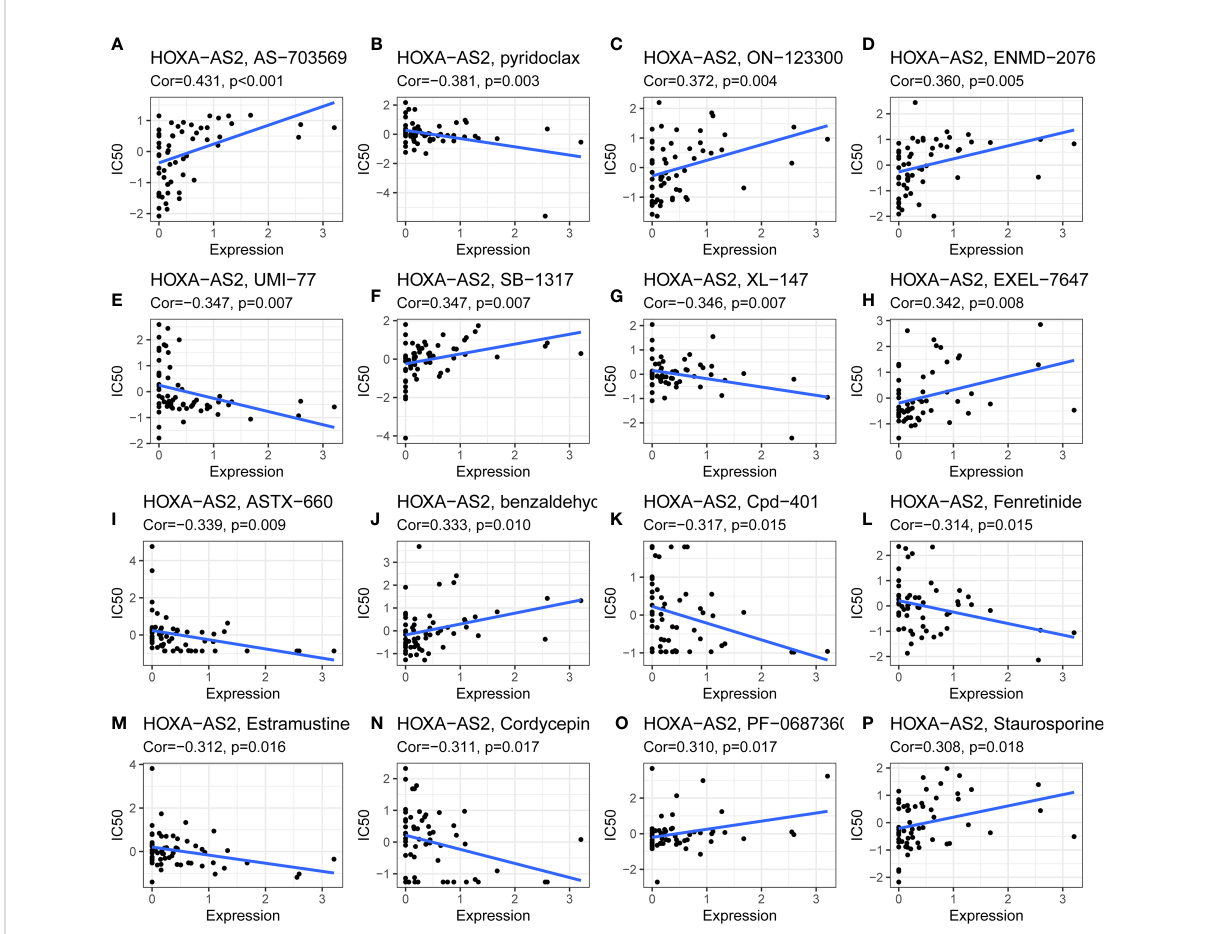
FIGURE 7 Drug sensitivity analysis of HOXA-AS2. The expression of HOXA-AS2 was associated with the sensitivity of (A) AS-703659, (B) pyridoclax, (C) ON-123300, (D) ENMD-2076, (E) UMI-77, (F) SB-1317, (G) XL-147, (H) EXEL-7647, (I) ASTX-660, (J) benzaldehyc, (K) Cpd-401, (L) Fenretinide, (M) Estramustine, (N) Cordycepin, (O) PF-0687360, (P)